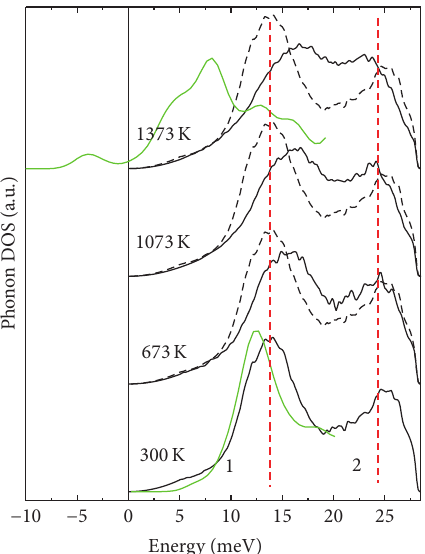
Figure 1: Neutron weighted phonon DOS of rutile TiO 2 from experimental measurements at temperatures from 300 to 1373 K with an incident energy of 30 meV (black). The dashed spectrum corresponds to the experimental result at 300K, shifted vertically for comparison at each temperature. Simulation results of peak 1 of phonon DOS from the QHA at 300 K and 1373 K are shown in green and compared with experimental